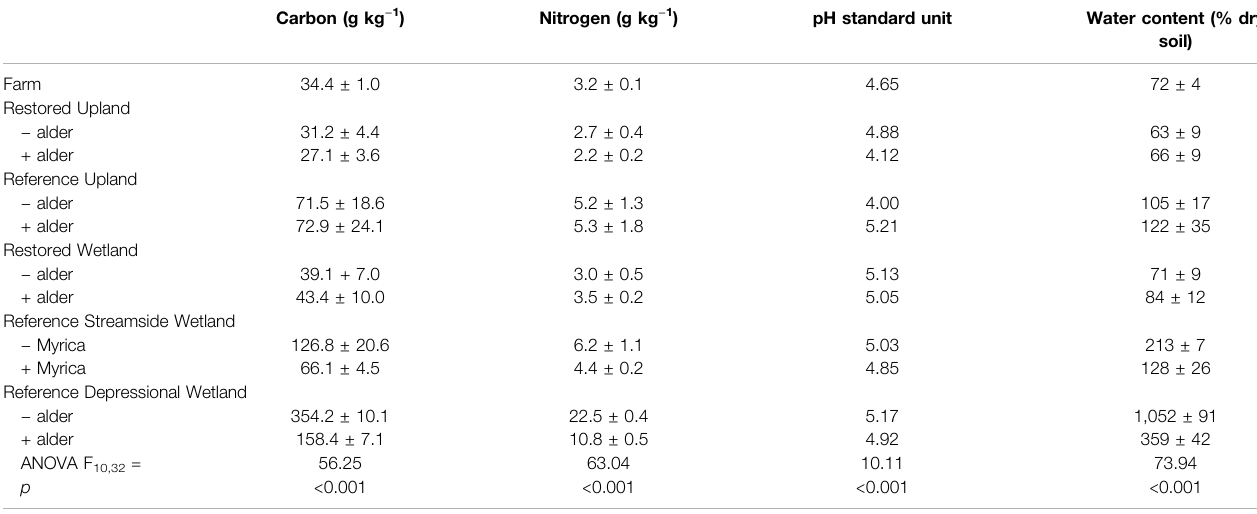
TABLE 1 | Carbon and nitrogen concentrations and pH of soils from the 11 sites investigated in this study.